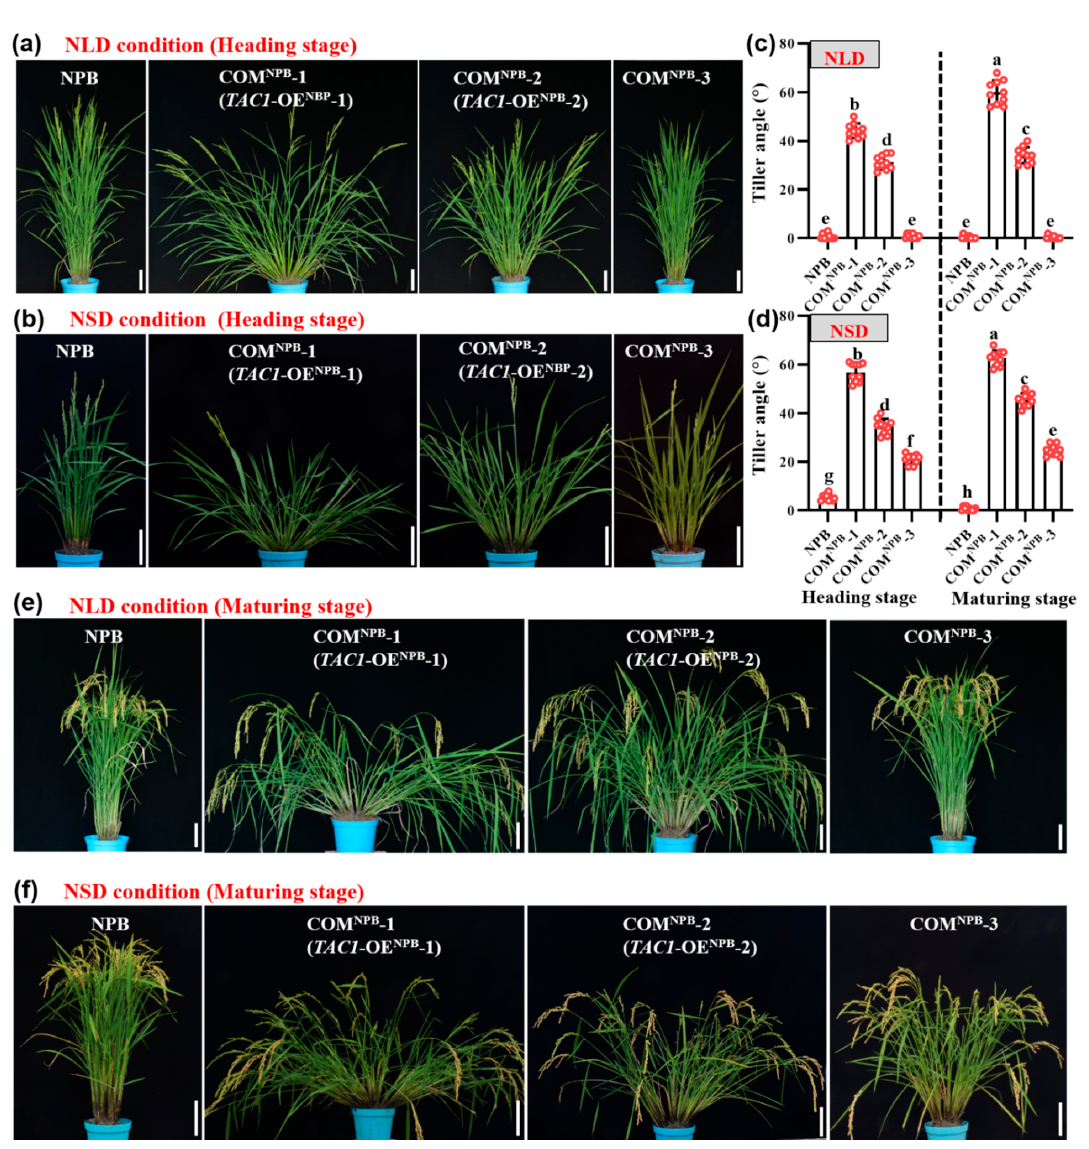
COM NPB -2 (renamed TAC1 -OE NPB -2) reached ~44.2° and ~31.2° at the tillering stage, and ~59.9° and ~34.1° at the heading stage, under NLD conditions (Figure 5c), corresponding to ~27.8° at the tillering stage and ~26.3° at the heading stage in the TAC1 -OE RIL-C -1 line under NLD conditions (Figure 3c). Under NSD conditions, the respective tiller angles of the TAC1 -OE NPB -1 and TAC1 -OE NPB -2 lines appeared to be ~56.8° and ~34.6° at the tillering stage, and ~62.7° and ~45.5° at the heading stage (Figure 5d), corresponding to ~30.0° and ~30.7° in the TAC1 -OE RIL-C -1 line under NSD conditions (Figure 4c). Altogether, the COM NPB lines showed different degrees of looseness in plant architecture, and the TAC1 -OE NPB -1 and TAC1 -OE NPB -2 lines had a looser plant architecture than TAC1 -OE RIL-C -1, indicating that TAC1 has a greater effect on plant architecture in NPB than in RIL-C.